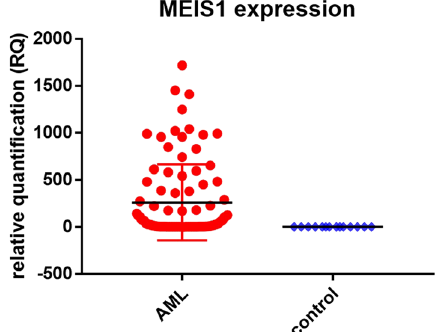
Fig. 3 Expression of MEIS 1 mRNA among adult AML cases and